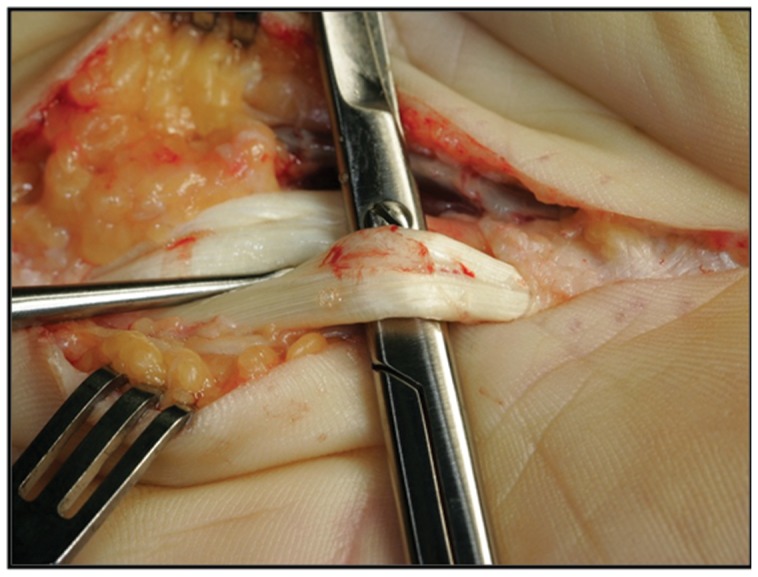
Further dissection revealing dense scarring of the flexor tendons with adhesions limiting tendon glide.